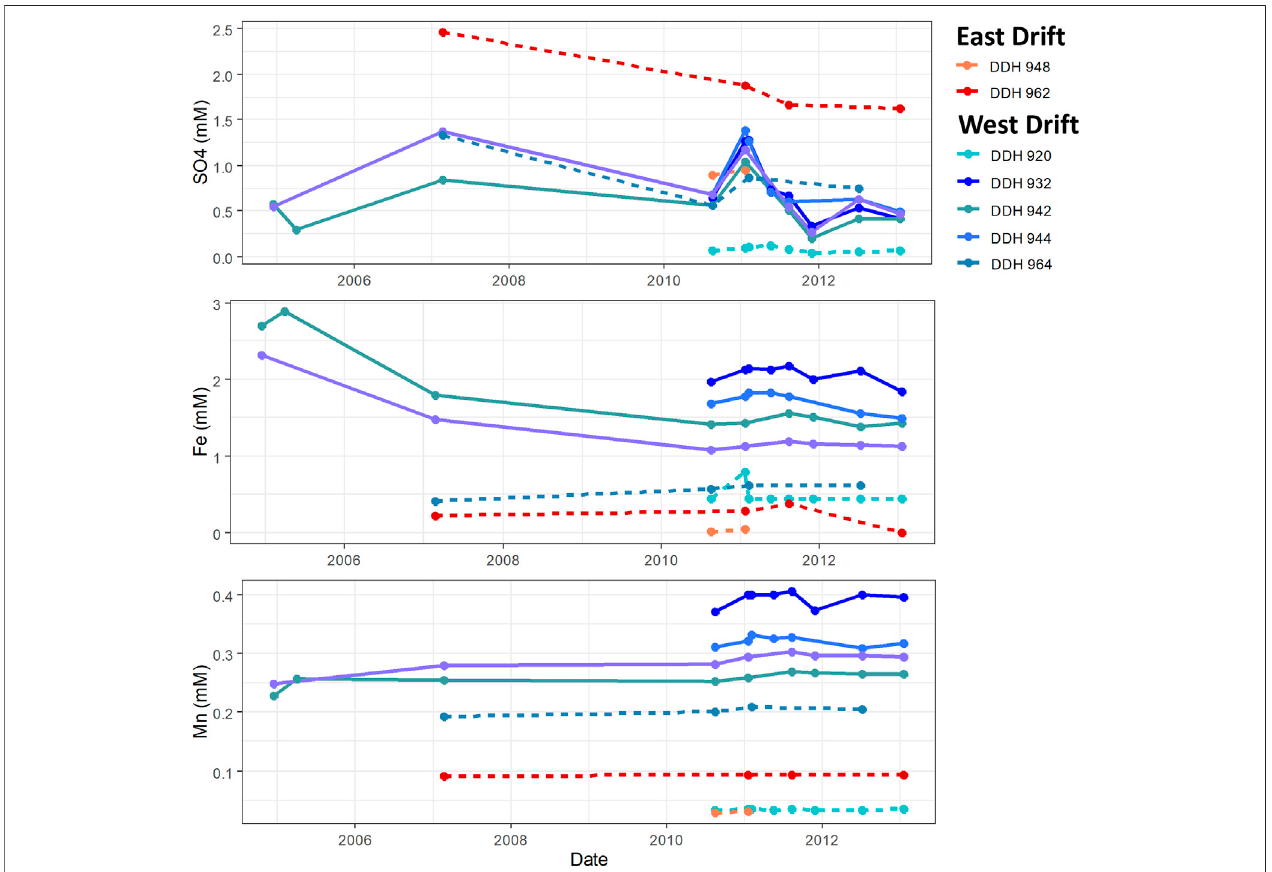
FIGURE 3 | Stability of the concentration of redox-sensitive solutes in Soudan boreholes. The Fe and Mn concentrations shown are of total Fe and total Mn, respectively. East drift boreholes areshown in shades ofred, while west drift boreholes areshown inshades ofblue. Solidlines indicate boreholes drilled at adownward angle, while dashed lines indicate horizontal or upward angled